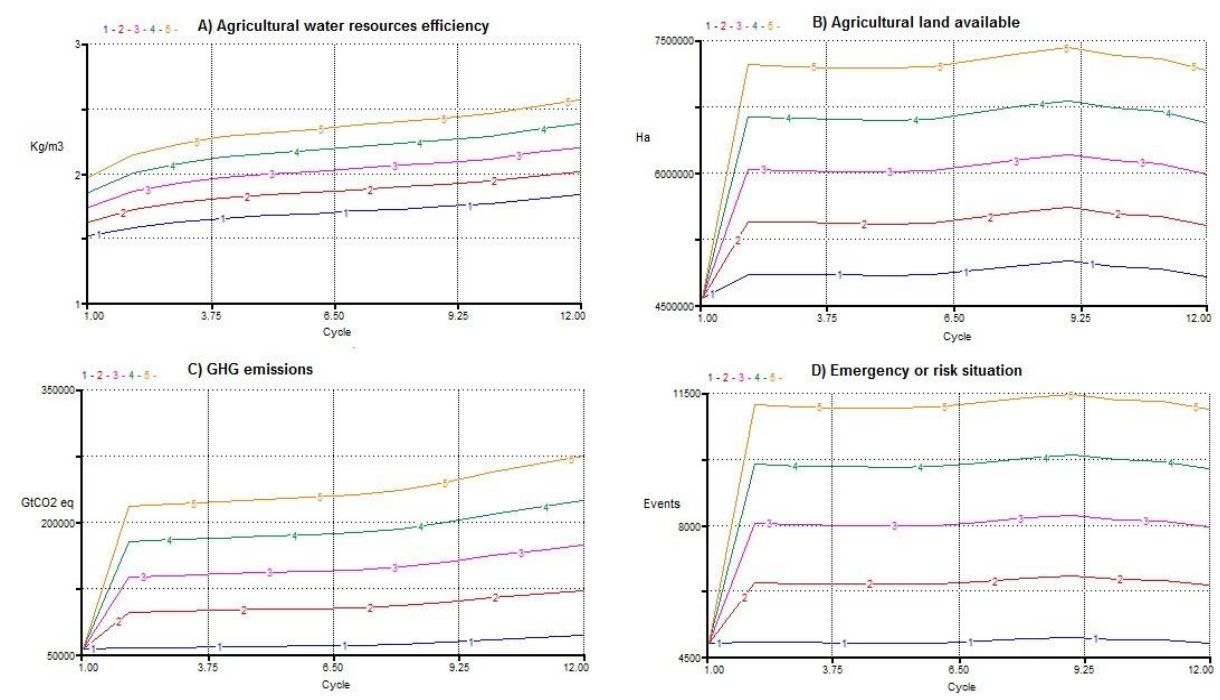
Figure 5. Sensitivity analysis of critical variables.